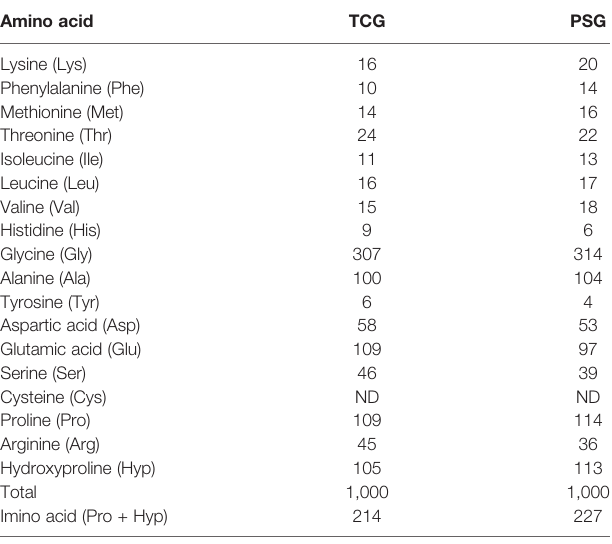
TABLE 3 | Amino acid composition of cartilage gelatin (TCG) from Siberian sturgeon and pigskin gelatin (PSG) (residues/1,000 residues). Amino acid TCG